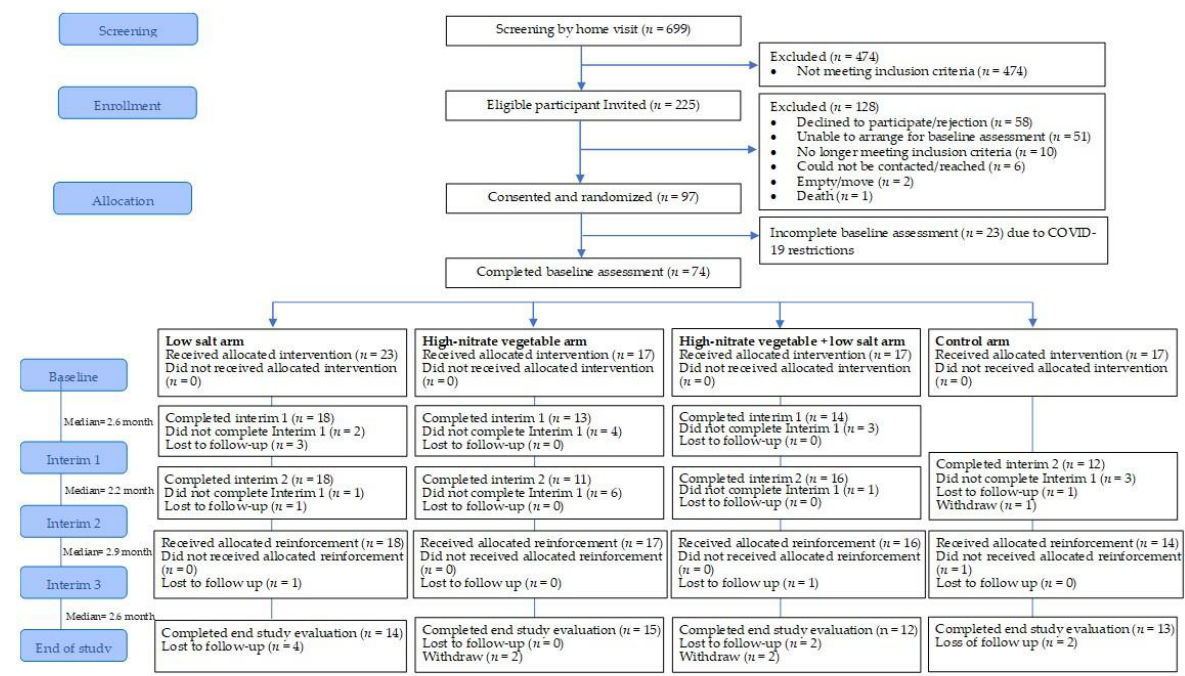
Figure 1. The flow of participants through the pilot study.